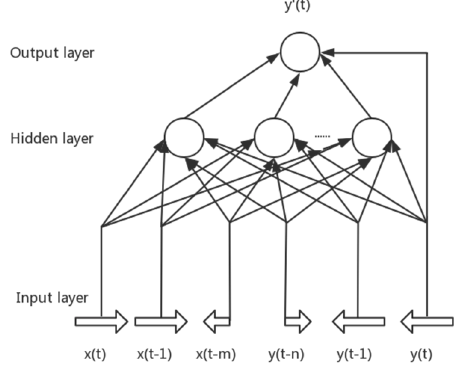
Figure 2. NARX network structure diagram.